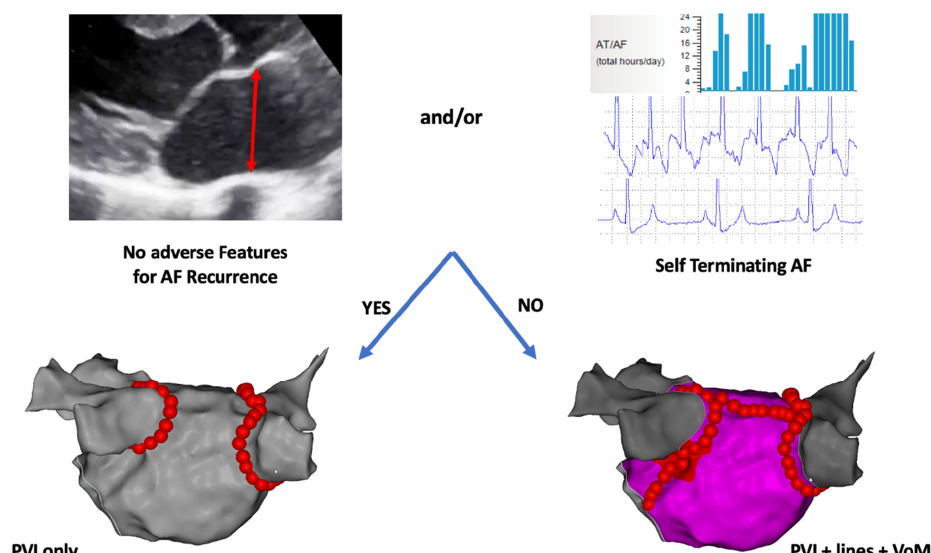
Figure 3. Proposed ablation strategy for persistent AF. Patients with no adverse features for recurrent AF (left atrial dilatation, fibrosis, etc.) and/or evidence of self-terminating AF on continuous monitoring undergo PVI only while those with adverse features or non-self-terminating AF undergo PVI plus linear ablation at the roof and mitral isthmus facilitated by Vein of Marshall ethanolization. VoM = Vein of Marshall (ethanolization).